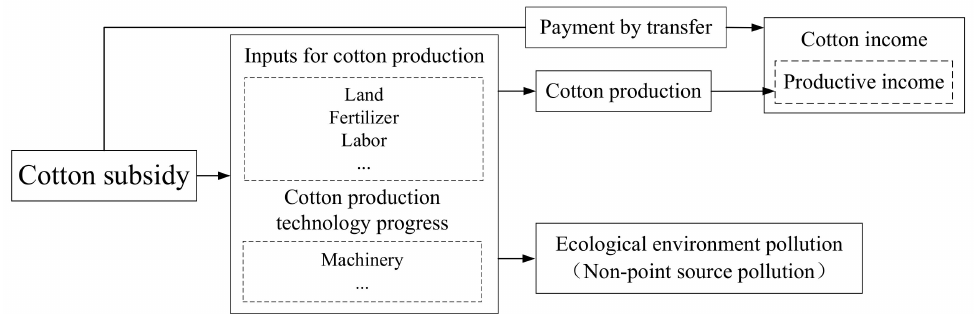
Figure 3. Theoretical framework of policy effects of cotton